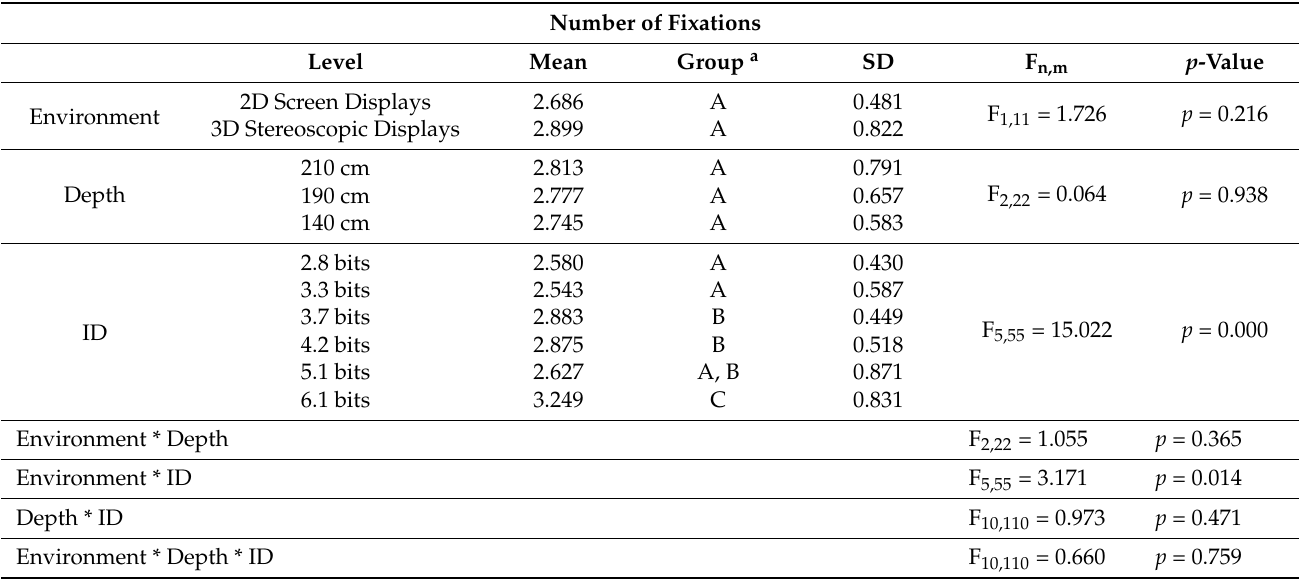
Table 5. Means, SDs, ANOVA, and Tukey HSD test results of number of fixations.